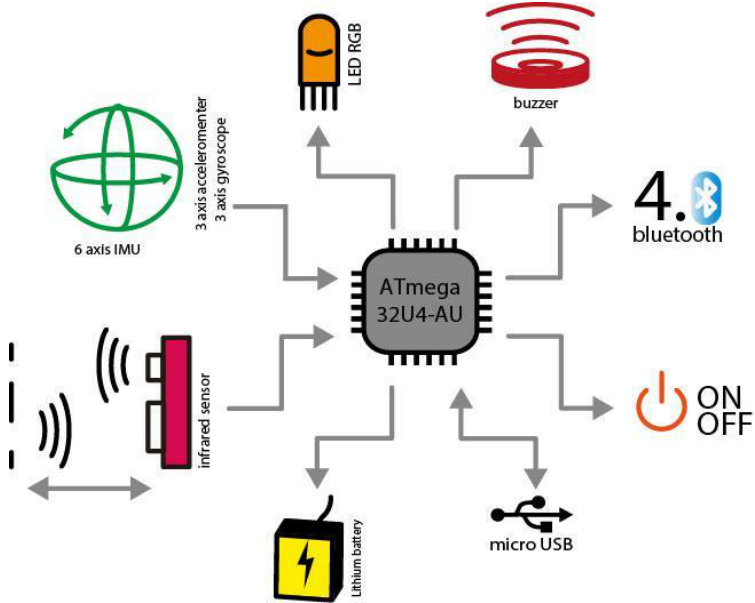
Figure 6. Technical components of the third version of HybridPLAY.